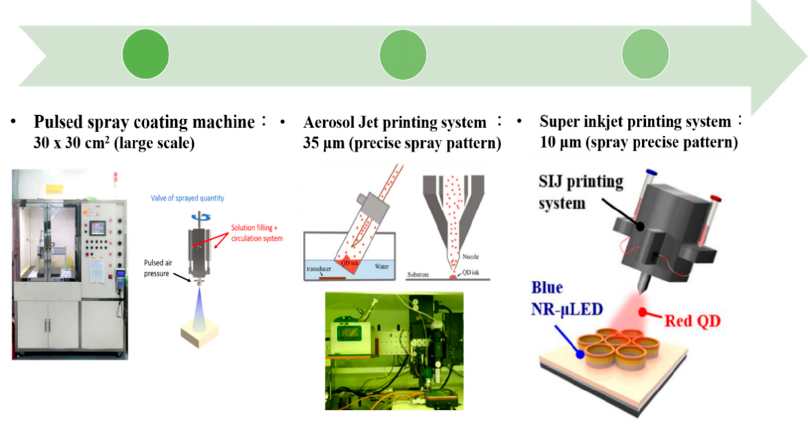
Figure 6. Developmental history of QD printing system at Kuo’s Lab [44, 46] . Figure reproduced with permission from Optical Society of America. Table 1. Development in QD patterning technology.